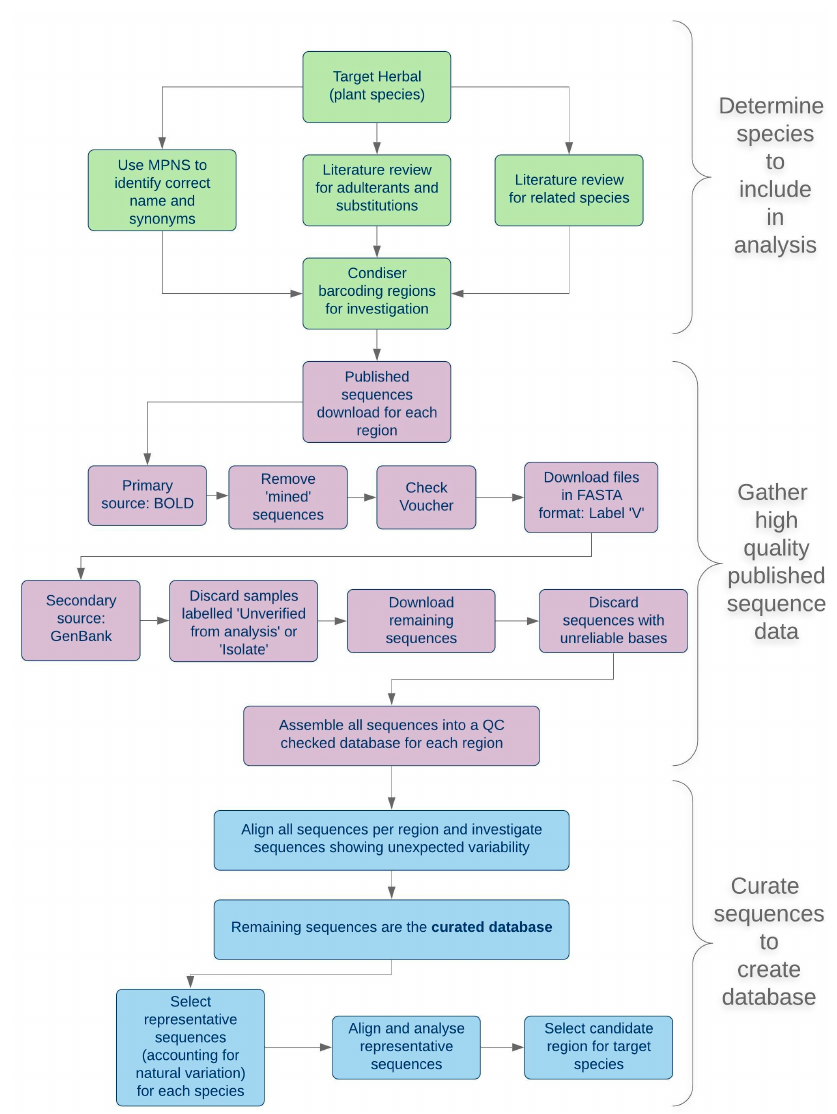
Figure 1. Flow diagram of DNA barcode region selection for discrimination of a commercial medicinal species from likely adulterant species. This shows a series of steps and decision points that can be used as a template to guide the choice of a suitable DNA barcode from published information through to laboratory